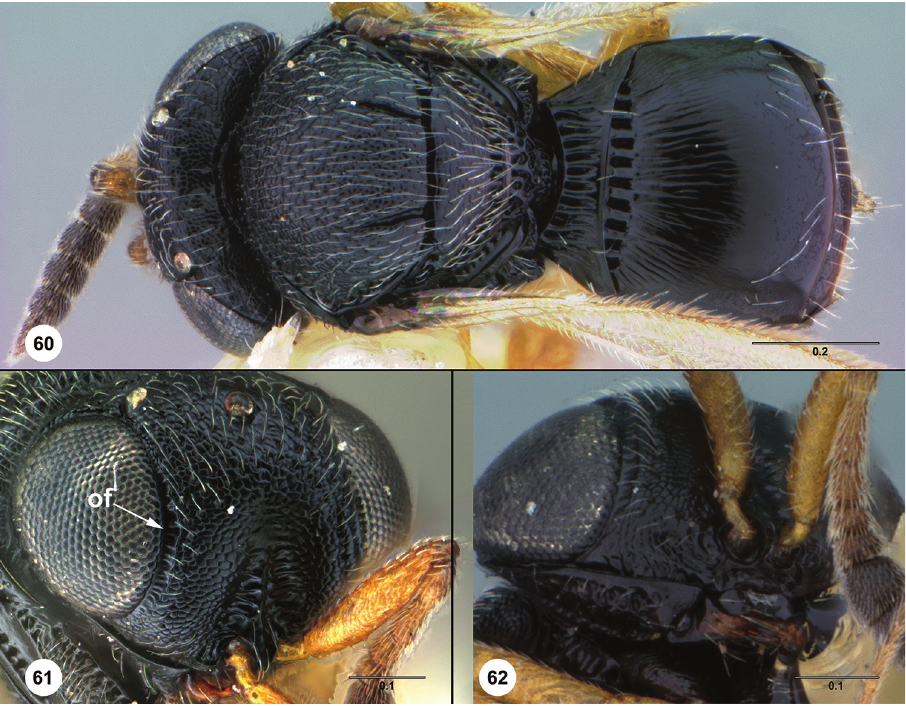
Figures 60–62. Trissolcus eriventus 60 female (USNMENT00916458), head, mesosoma, metasoma, dorsal view 61 female (USNMENT00916457) 62 female (USNMENT00916458). Scale bars in millimeters. by open crenulae. Mesofurcal pit: absent. Setation of posteroventral metapleuron: ab- sent. Sculpture of dorsal metapleural area: rugose. Posterodorsal metapleural sulcus: poorly defined to absent. Paracoxal sulcus in ventral half of metapleuron: indistin- guishable from sculpture to absent. Anteroventral extension of metapleuron: extending to base of mesocoxa. Metapleural epicoxal sulcus: present as coarse rugae. Mesoscutal humeral sulcus: indicated by a line of cells. Median mesoscutal carina: absent. Macrosculpture of mesoscutum: absent. Pattern of mesoscutal microsculpture: uniform throughout. Mesoscutal suprahumeral sulcus: comprised of cells. Length of mes- oscutal suprahumeral sulcus: about half the length of anterolateral edge of mesoscutum. Parapsidal line: present. Notaulus: extending at least 1/3 length of mesoscutum. Median protuberance on anterior margin of mesoscutellum: uncertain, absent; uncertain, pre- sent. Protruberance on anterior margin of mesoscutellum directly posterior to notaulus: absent; present. Shape of dorsal margin of anterior lobe of axillar crescent: round. Sculp- ture of anterior lobe of axillar crescent: dorsoventrally strigose. Area bounded by axillar crescent: punctures visible in at least ventral half, not quite striate. Macrosculpture of mesoscutellum: absent. Microsculpture on mesoscutellum: present throughout. Setation of posterior scutellar sulcus: present. Form of metascutellum: coarsely rugose. Metanotal trough: foveate, foveae occupying more than half of metanotal height.